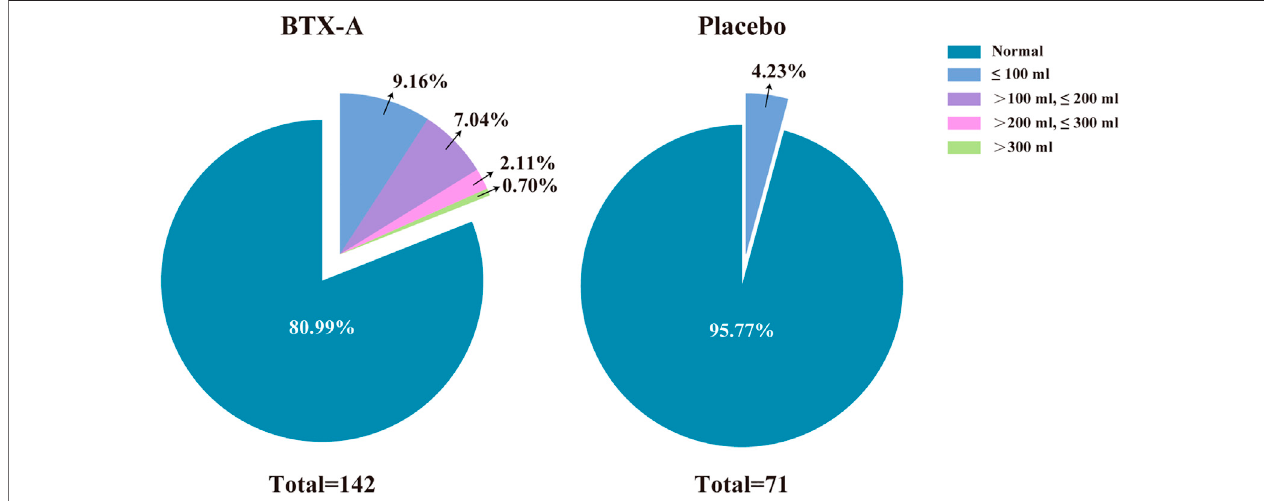
FIGURE 3 | Proportion of safety population with increased PVR during the primary treatment